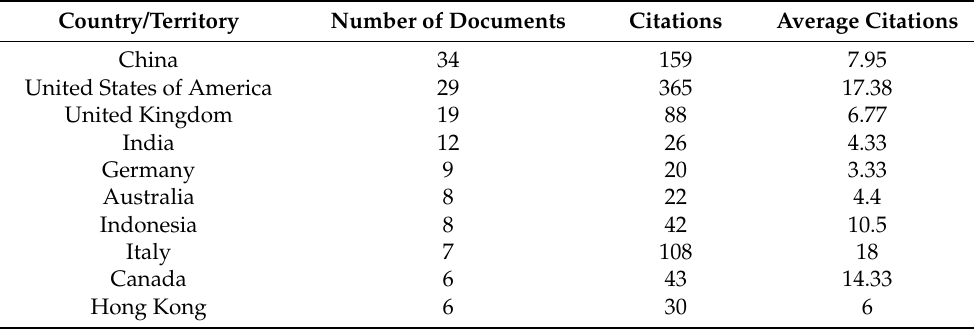
Table 5. Most influential countries in fintech and social protection